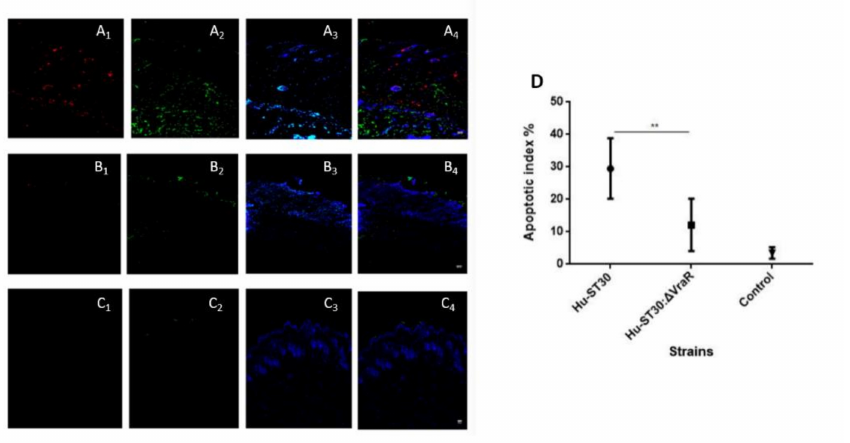
Figure 7. Comparison of MRSA ST30 and ST30 ∆ vraR using skin and soft-tissue infection (SSTI) model. Mice were inoculated subcutaneously with either PBS or bacteria as described in Methods. ( A ) A double-labeling assay for detection of the staphylococcal invasion of the skin model with anti- Staphylococcus aureus antibody and detection of the apoptotic cells, using TUNEL assay after 48 h of infection with the MRSA. ( A ) ST30 and ( B ) ST30 ∆ vraR , and ( C ) PBS ( 1 ) anti- Staphylococcus aureus antibody with goat anti-rabbit IgG H and L conjugated with Alexa Fluor 568 secondary antibody, ( 2 ) the Click-iT ® TUNEL Alexa Fluor ® 488 cells ( 3 ) Hoecsht stain, and ( 4 ) the overlay of the emission signals. White hashed line demarcates the dermal epidermal boundary between the strata basale and the collagen gel populated with fibroblasts. Scale bar shows 50 µ m. ( D ) Apoptotic index. Ten fields were calculated for each condition and original magnifications of images are 100 × . Data are